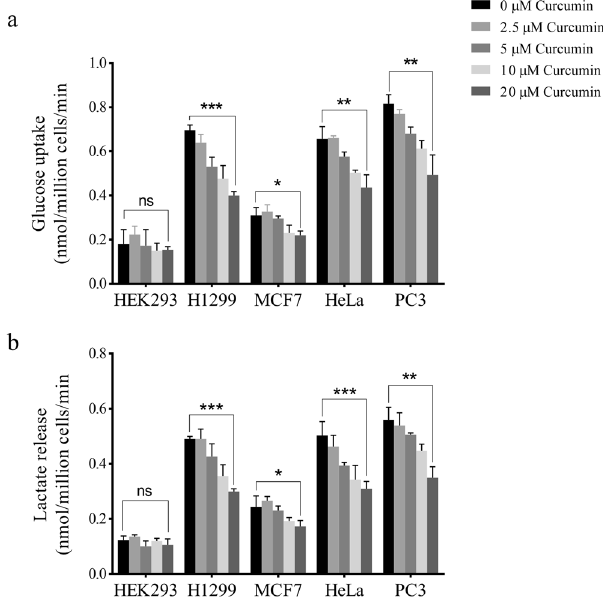
Figure 1. Dose-dependent effect of curcumin on Warburg effect. High glucose uptake and lactate production, also referred to as Warburg effect, is a hallmark feature of cancer cells (see text) needed to support proliferation of cancer cells. Glucose uptake ( a ) and lactate release ( b ) by H1299, MCF-7, HeLa and PC3 cells was reduced significantly upon curcumin treatment compared with HEK293 where the change in glucose and lactate was not significant. Different doses of curcumin (2.5, 5, 10 and 20 μ M) for 24 hours were used for treatment purpose. Maximal decrease in Warburg effect was observed at 20 μ M. Error bars represent mean ±